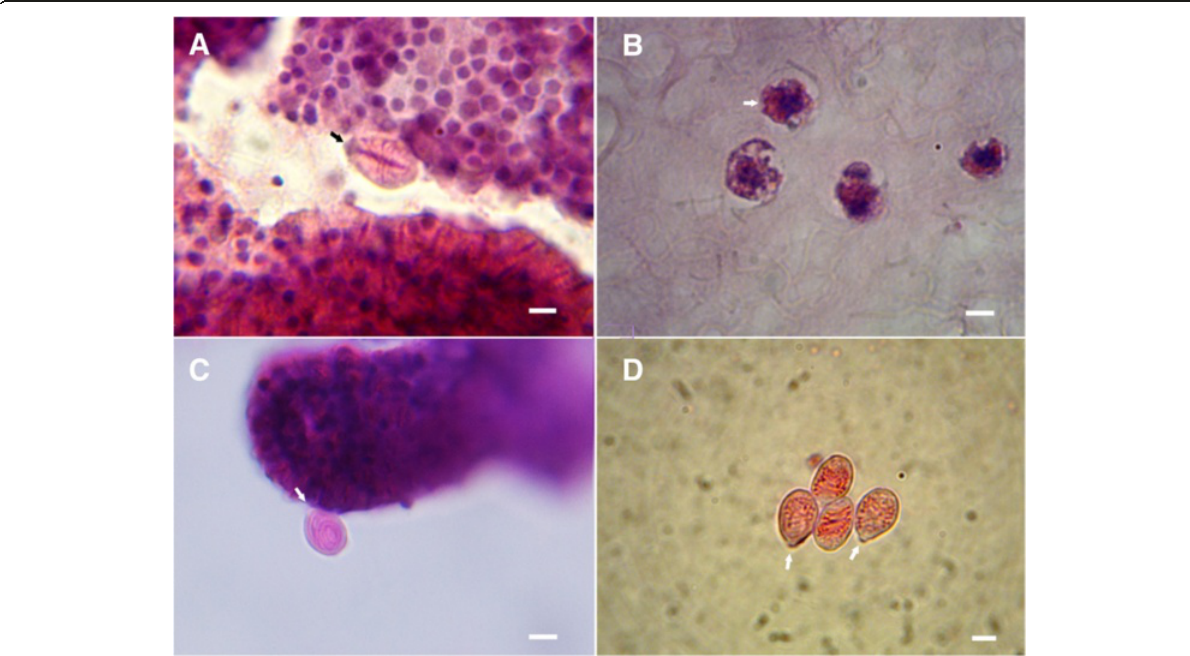
Fig. 3 Nematocytes of C. tagi viewed with hematoxylin and eosin staining using optical microscopy. Purple dots indicated nucleus cells; cationic structures coloured red/pink. Arrows in (A, C, D) highlight operculum. a Adult eurytele surrounded by developing nematocytes. b Arrow points out to early stage of nematocyst morphogenesis ( orange ), developing in the gastric region. c Adult birhopaloid near to developing nematocytes. d Adult isorhizae. Bars: ( a ) 4 μ m; ( b ) 3 μ m; ( c and d ) 7 μ